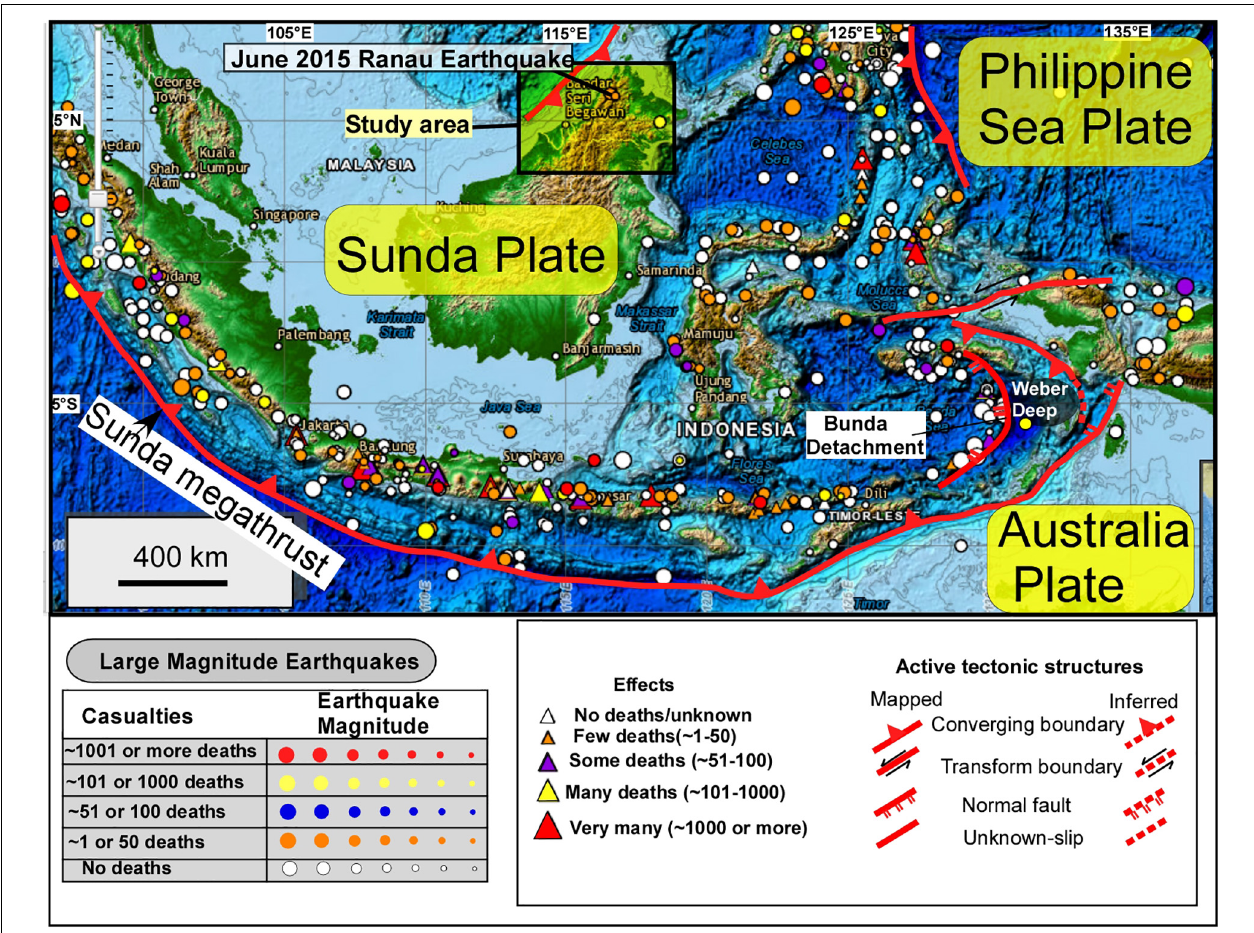
FIGURE 1 | Regional tectonic map of SE Asia (after Shah et al., 2018c) shows the distribution of lithospheric plates and the location of earthquakes, volcanoes, and some of the major active fault systems. The earthquake and plate boundary data (some boundaries are modified herein) are obtained from the National